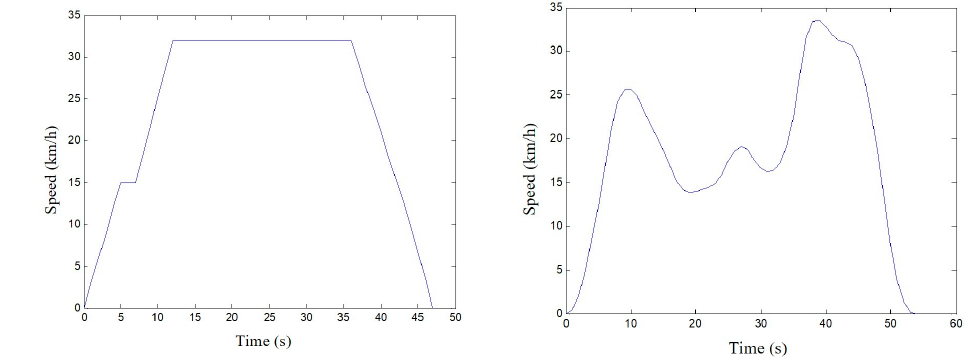
Figure 18. Typical working condition A and B.